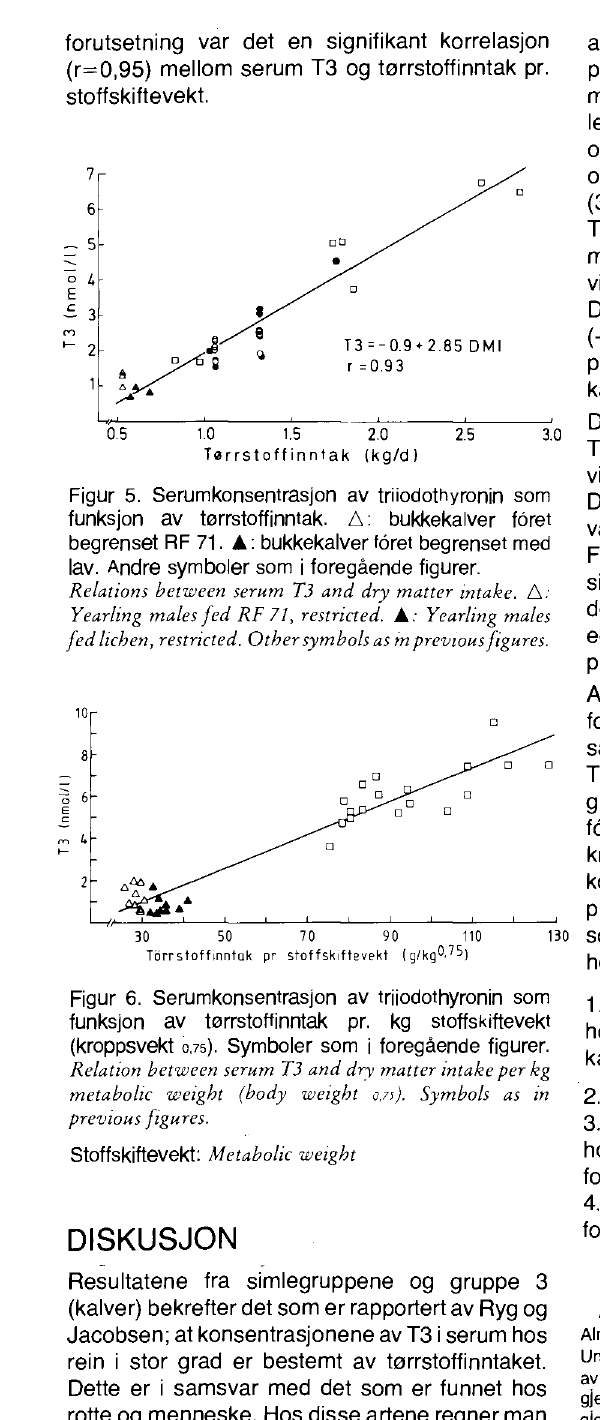
Figur 6. Serumkonsentrasjon av triiodothyronin som funksjon av tørrstoffinntak pr. kg stoffskiftevekt (kroppsvekt 0,75). Symboler som i foregående figurer. Relation between serum T3 and dry matter intake per kg metabolic weight (body weight 07s). Symbols as in previous